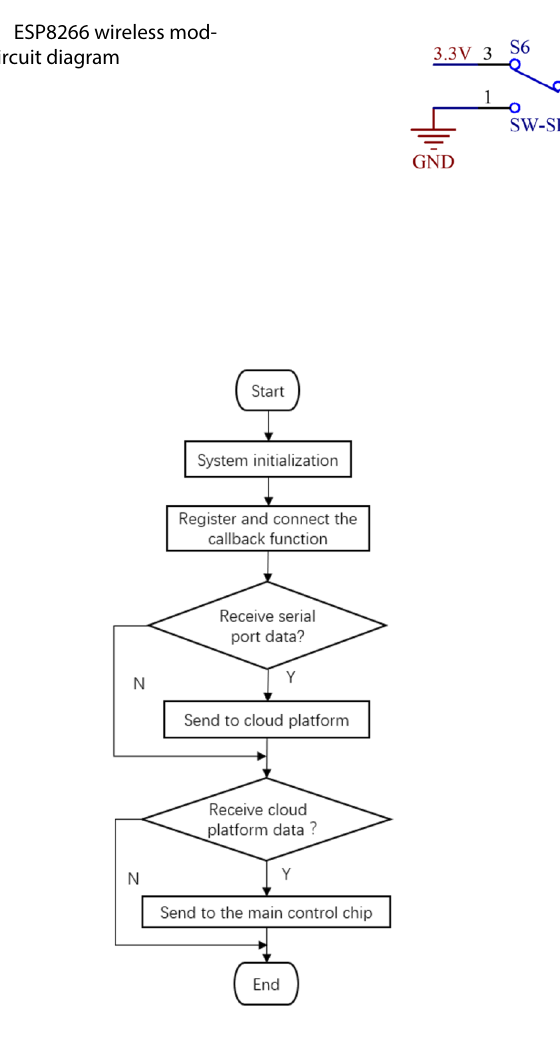
Fig. 10 Wireless communication module software driver flowchart